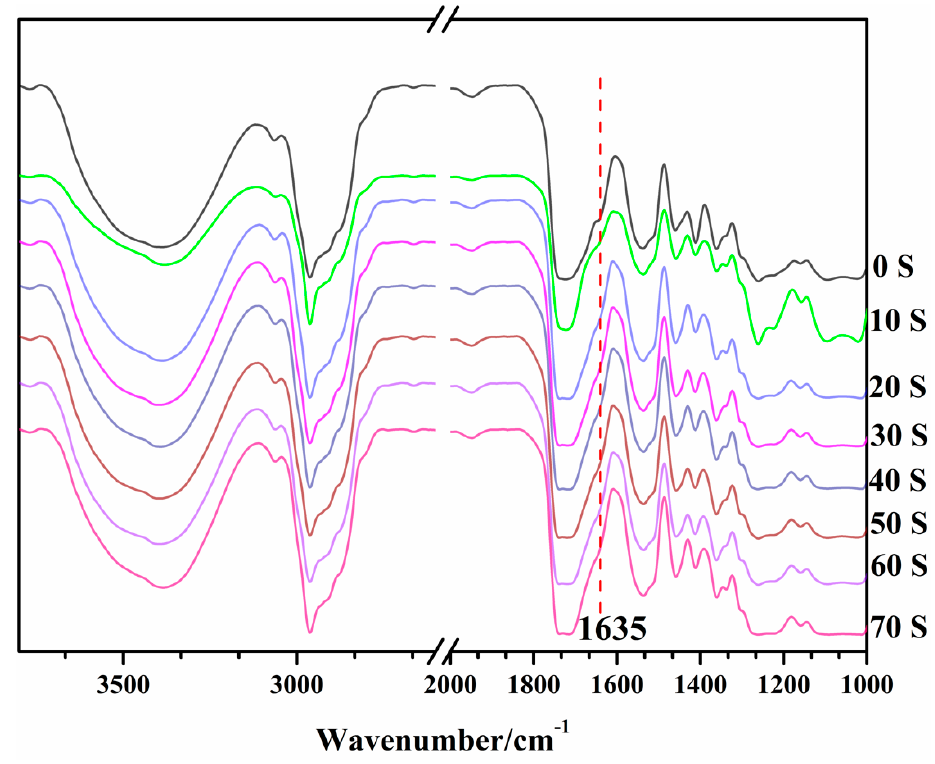
Figure 6. The UV-curable behavior of SG01 as monitored by FT-IR.